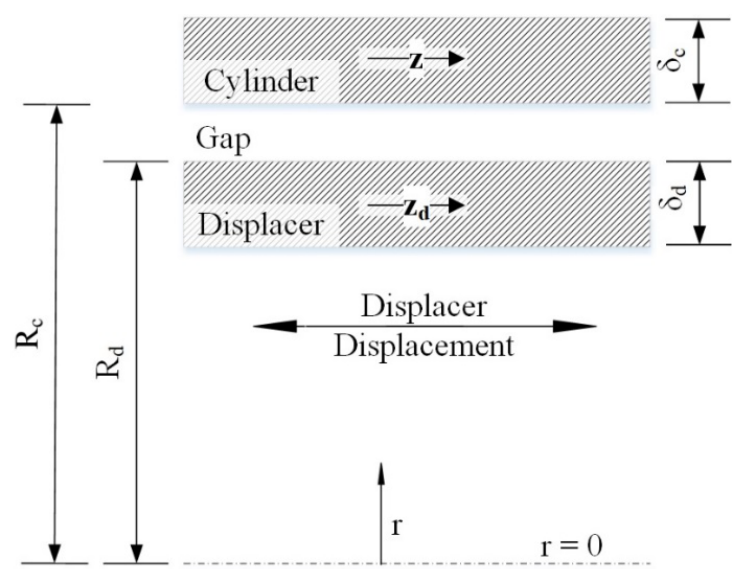
Figure 7. Gap coordinates.